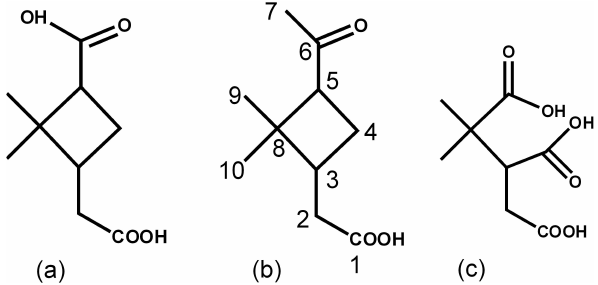
Fig. 1. Structure of (a) pinic acid (M w 186da), (b) pinonic acid (M w 184da) and (c) MBTCA (M w